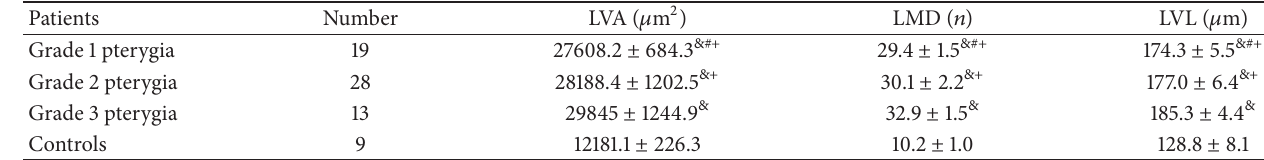
Figure 1: Lymphatic vessel endothelial hyaluronan receptor 1 (LYVE-1) immunohistochemistry for normal human conjunctiva and recurrent pterygia.AsmallnumberofLYVE-1positivelymphaticvesselswerefoundinGrade1(a)and2(b)recurrentpterygia.Thenumberoflymphatic vessels was increased in Grade 3 (c) recurrent pterygia. The number of lymphatic vessels in normal human conjunctiva was decreased compared with that in pterygium patients. Only a few lymphatic vessels were positive for LYVE-1 in the normal epibulbar conjunctival segments (d) (green arrows indicate lymphatic vessels; magnification: A 1 , B 1 , C 1 , and D 1 × 100; A 2 , B 2 , C 2 , and D 2 × 200). Table 2: Comparative evaluation of lymphatic vessels in recurrent